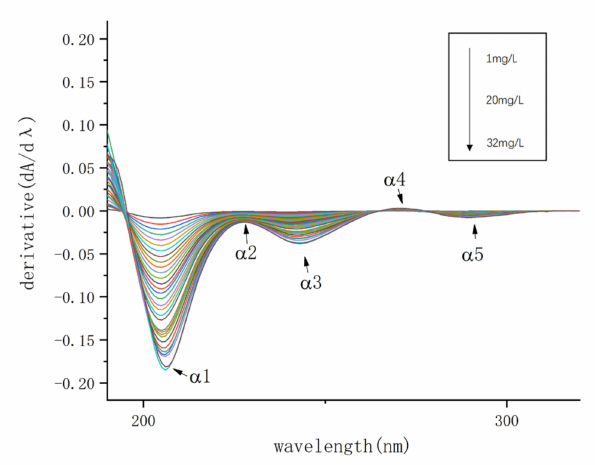
Figure 4. The first derivative spectra of COD standard solution absorption spectra, where α 1 is the first extreme point, α 2 is the second extreme point, α 3 is the third extreme point, α 4 is the fourth extreme point, α 5 is the fifth extreme